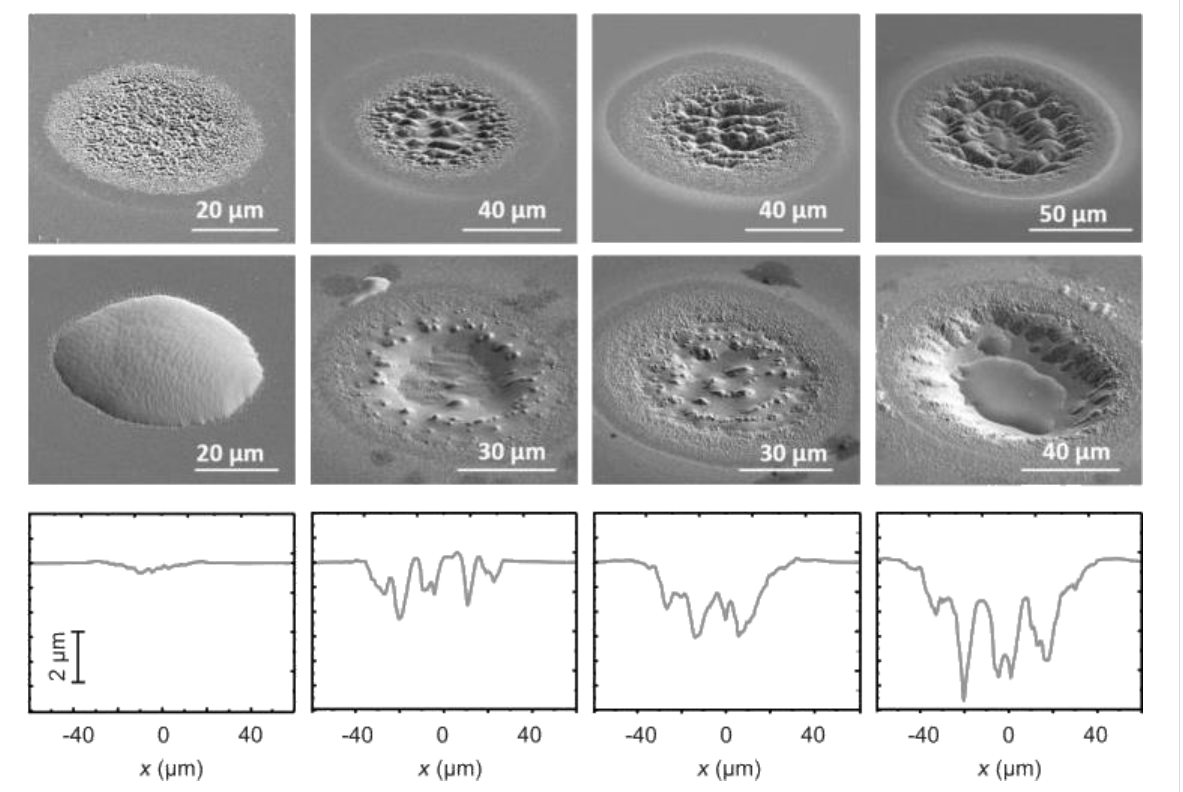
Figure 6: Scanning electron micrographs of individual laser-generated ablation spots on glass (top row) and corresponding profilometric cross sections (bottom row). Spots after deposition of molybdenum and indium (middle row). Laser parameters from left to right: F = 1.63 J/cm 2 , N = 100; F = 1.83 J/cm 2 , N = 30; F = 1.83 J/cm 2 , N = 100; F = 2.04 J/cm 2 , N =